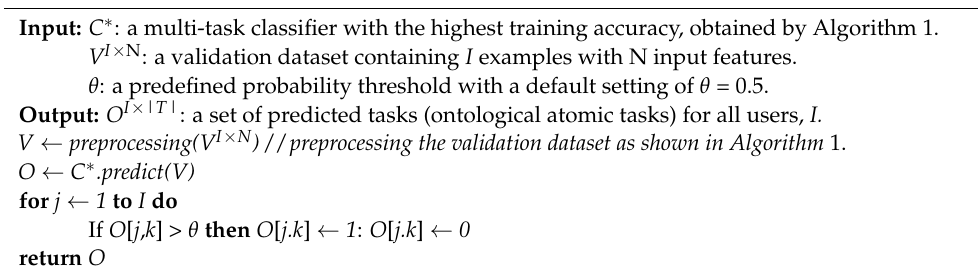
Algorithm 2: Validation procedure to predict a set of tasks, T , using C ∗ classifier for each disabled user.